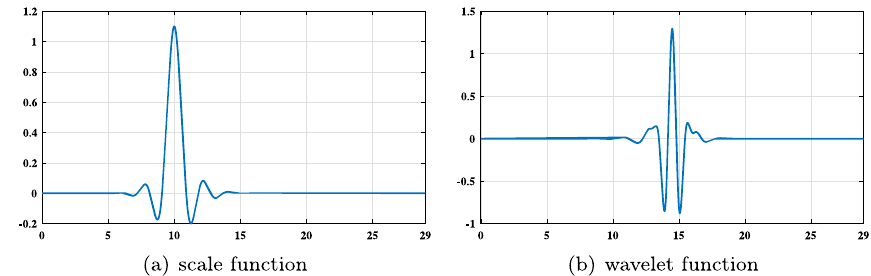
Fig. 3 The function of the Coiflet5